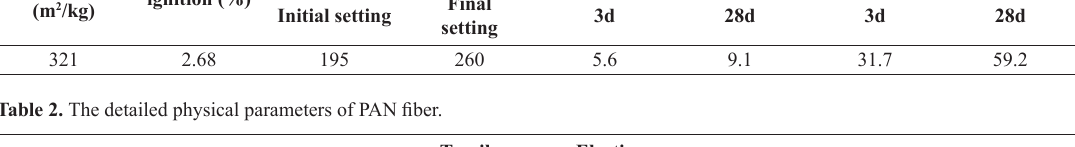
Table 1. The detailed physical parameters of Ordinary Portland cement 42.5R. Specific surface area